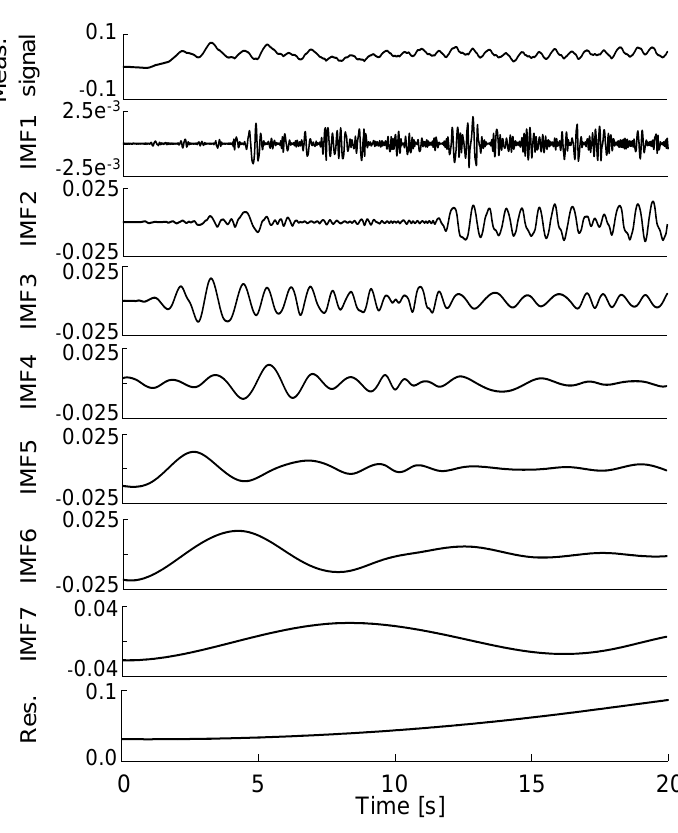
Figure 3. Representative normalized IMF decomposition of the integrated angular velocity obtained for the first 20 s of one randomly selected treadmill walking trial. All the IMFs are expressed in